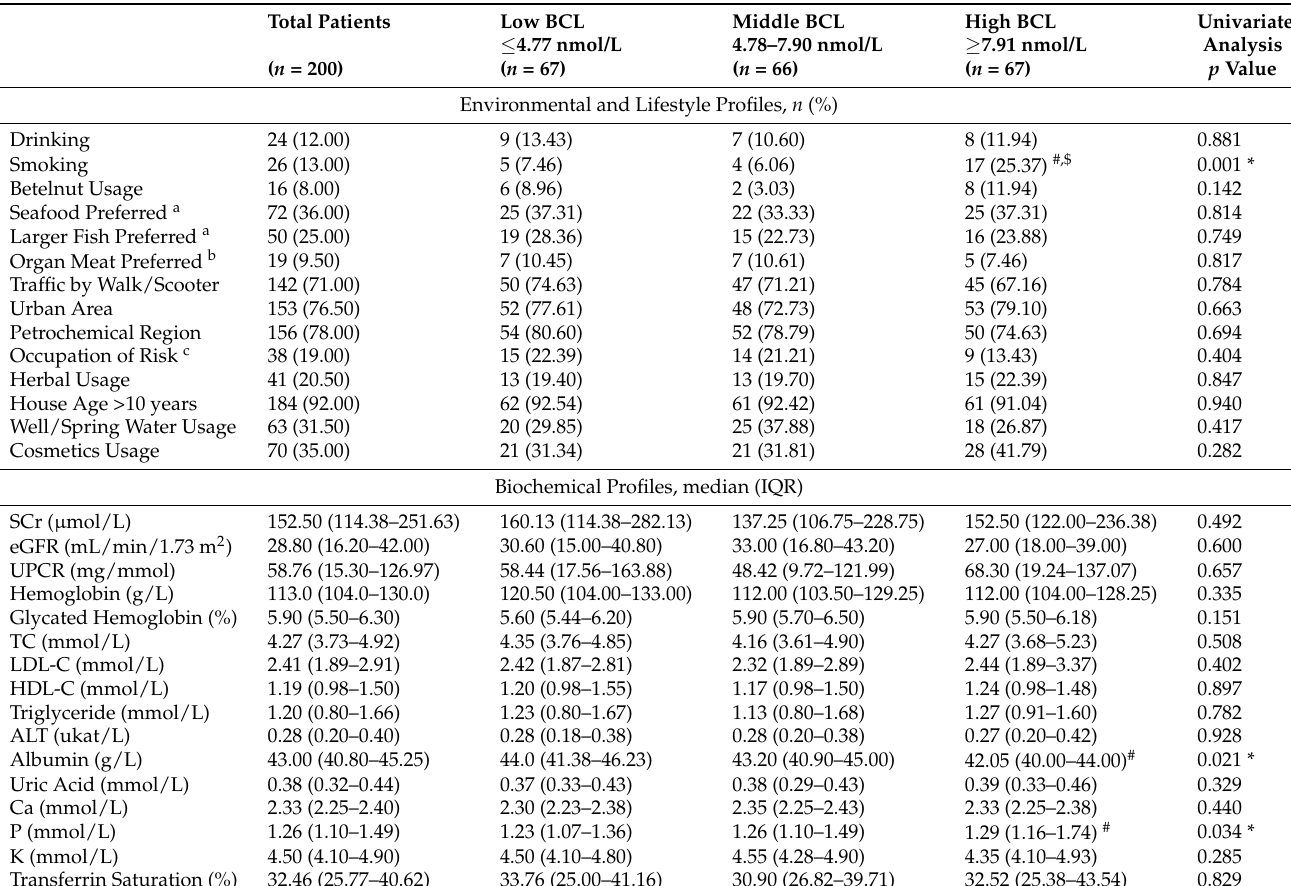
Table 2. Differences in Environmental, Lifestyle and Biochemical Profiles Between Three BCL Subclasses.